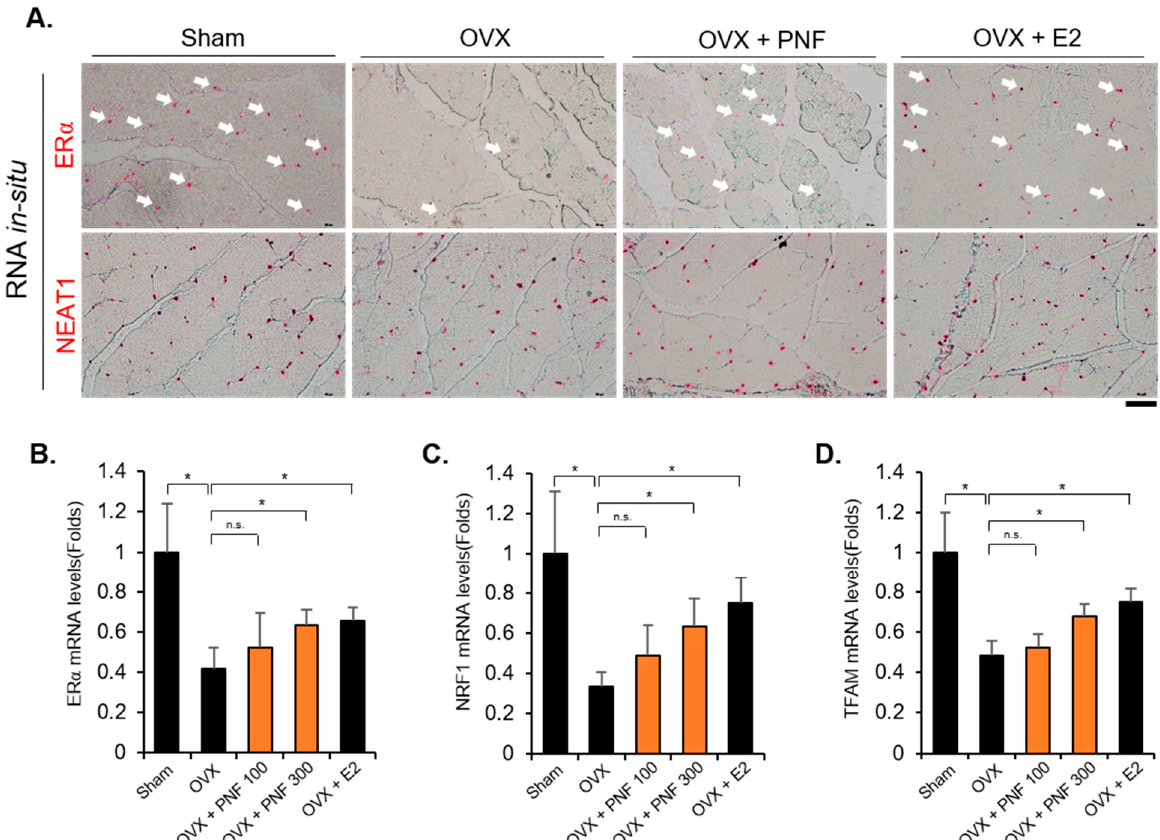
Figure 5. Suppressed ER α , NRF1, and TFAM levels are rescued by PNF in TA muscle of OVX mice: ( A ) RNA in situ hybridization staining for ER α and Neat1 (red) in TA muscle ( n = 3). Neat1 was used as an internal control. Magnification × 40, Scale bar, 50 µ m. ( B ) Representative ER α mRNA in situ hybridization signals from TA muscle. PNF was tested at 300 mg/kg/day on OVX mice. E2 was used as a positive control. ( C , D ) Expression of mRNA levels of NRF1 and TFAM in TA muscle. n = 3. * p < 0.05. N.S., not significant.